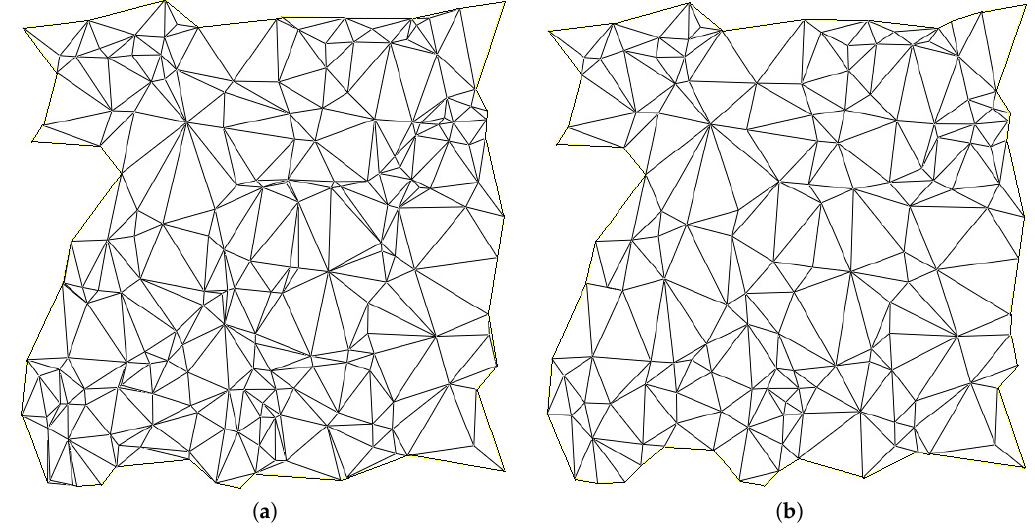
Figure 4. ( a ) A triangular mesh with too many skinny triangles is constructed from a network based on the algorithm proposed in [25]. Its maximal r f value is close to 27. ( b ) After a series of short edge collapse operations, the maximal r f value of the triangular mesh is less than